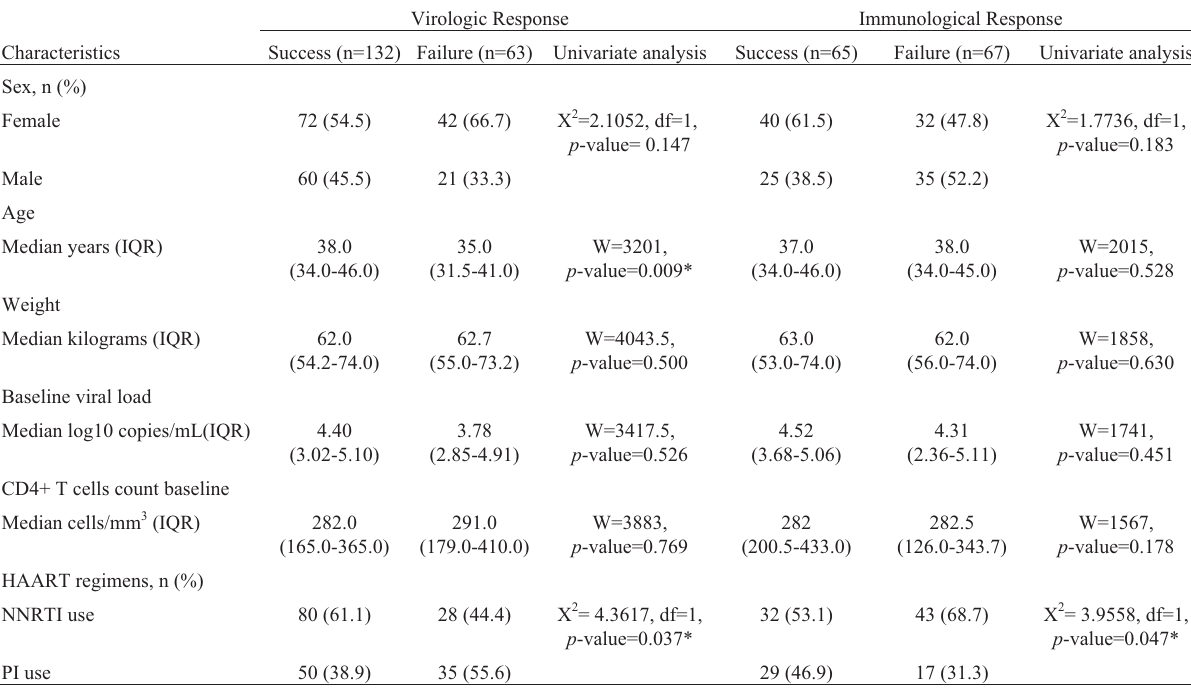
Table 1 - Clinical and Epidemiological characteristics of the study